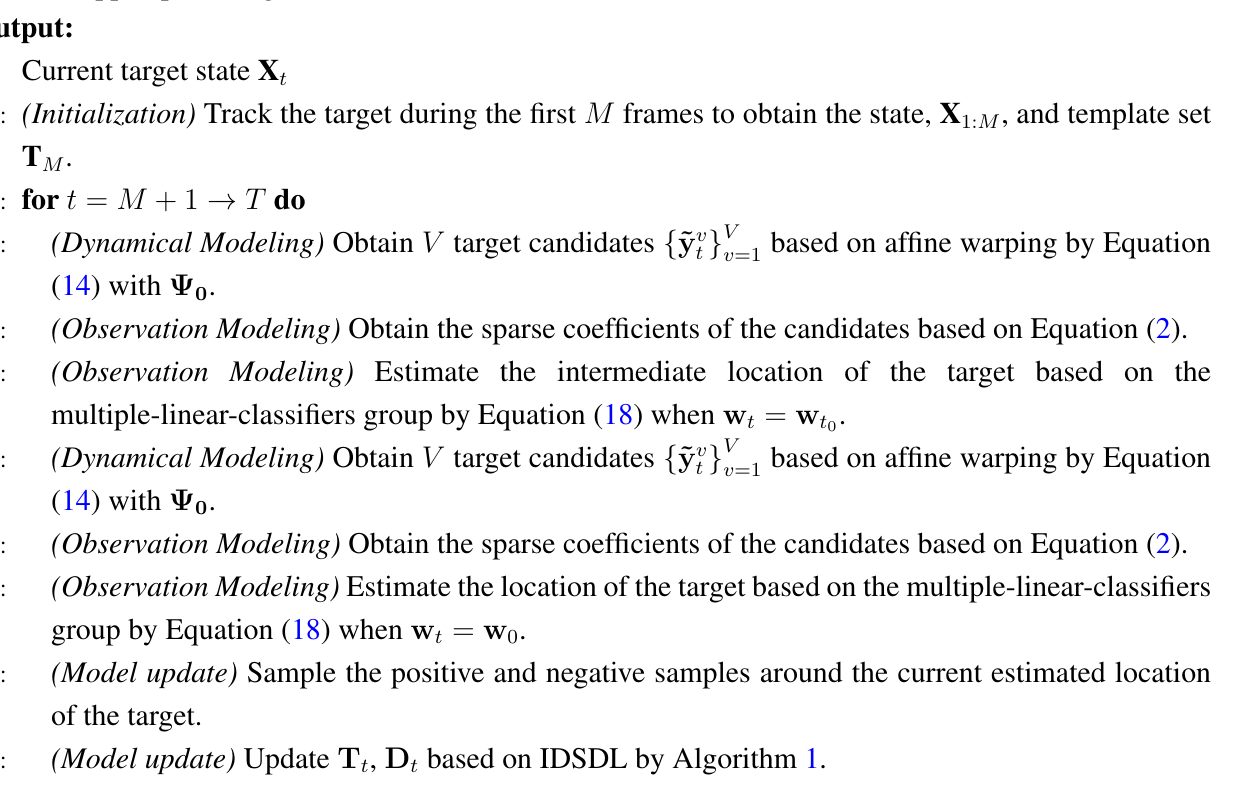
Algorithm 2 Visual tracking based on IDSDL and K-combined voting SVM